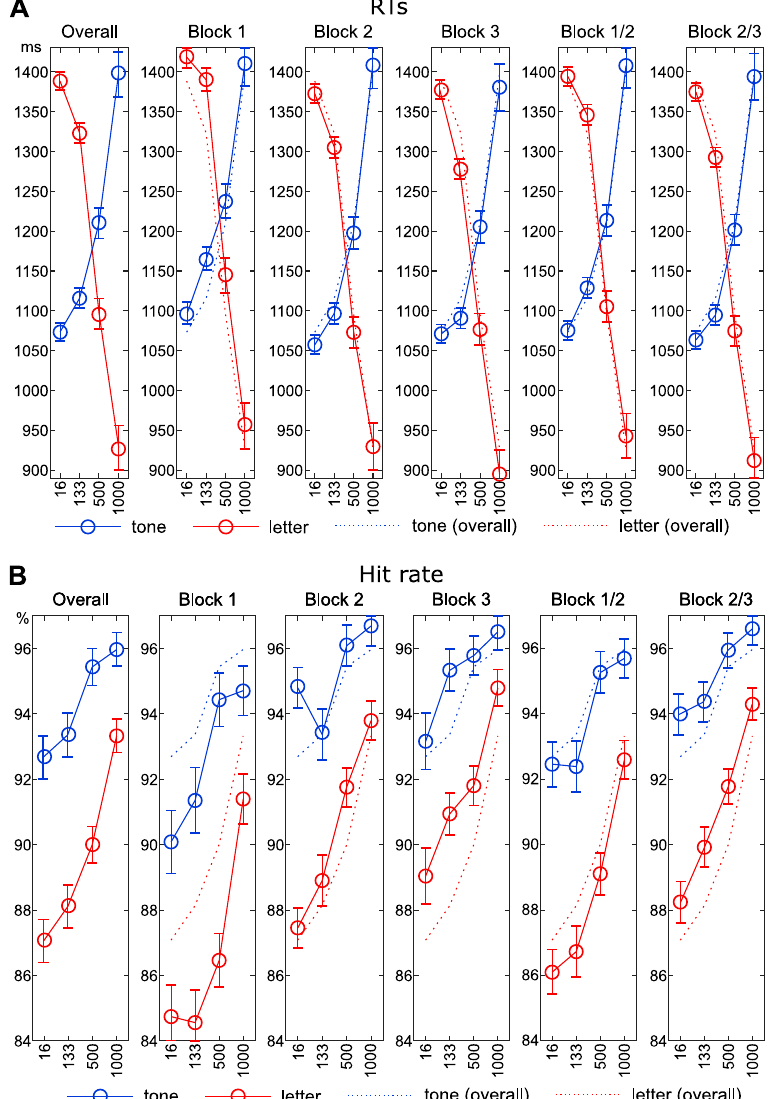
Figure 2. RTs ( A ) and hit rates ( B ) for the tone and letter stimulus, separately for the entire test (overall), for each block, aggregated for block 1 and 2 as well as for block 2 and 3. The x -axis denotes the stimulus-onset asynchrony (SOA), the y -axis denotes the RT in ms ( A ) or accuracy rate in % ( B ). Error bars indicate standard error of the mean (SEM). The line color denotes tone stimulus (blue) or letter stimulus (red). The dashed line indicates data from overall blocks for